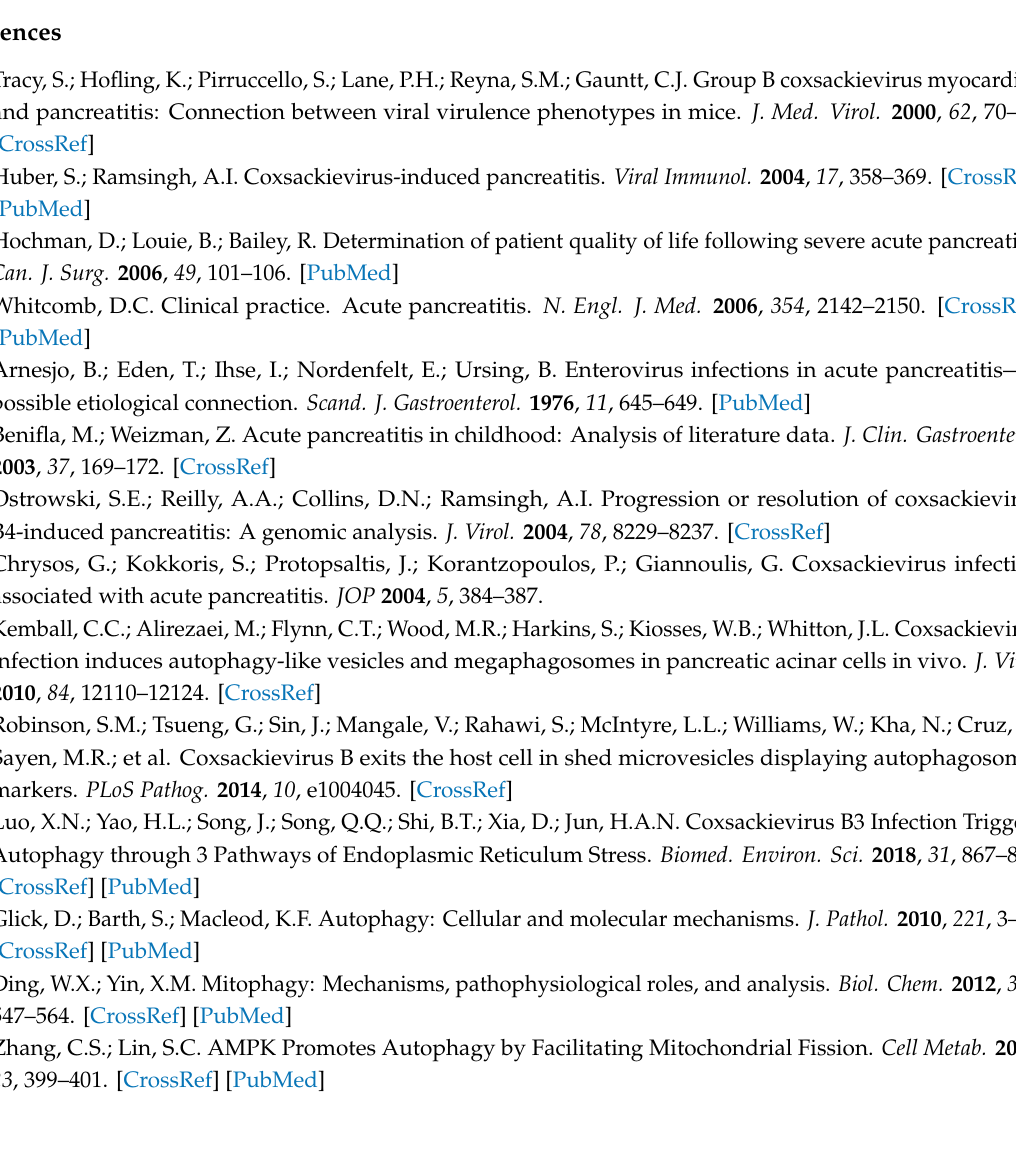
Figure S1: Cell viability following SB-366791, menthol, or siTRPM8 treatment, Figure S2: Menthol causes mitochondrial elongation, Figure S3: Menthol-treated animals exhibit lesser degree of CVB-induced pancreatic damage, Figure S4: Menthol does not a ff ect non-infection cerulein-induced